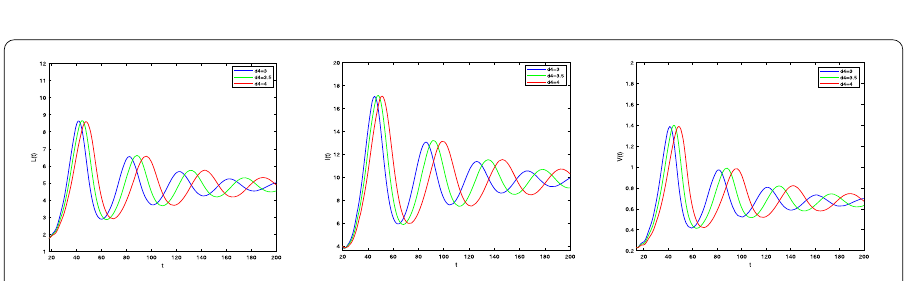
Figure 8 The effect of d 4 on the dynamical behavior of model